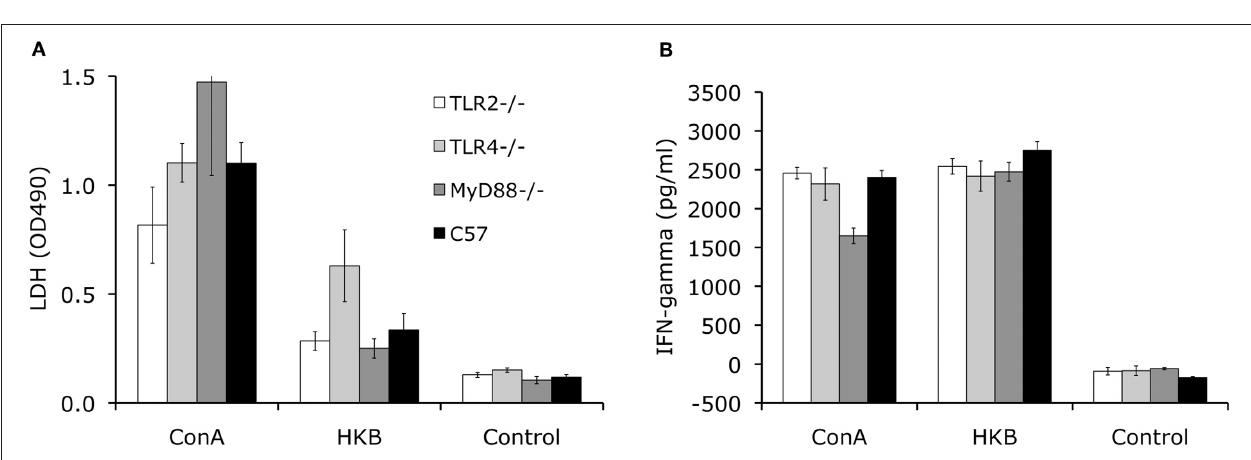
proliferation was determined using LDH release assay (A) . IFN- γ levels in the culture supernatants were determined via ELISA (B) . Data shown was a representative of three independent experiments. Error bars,